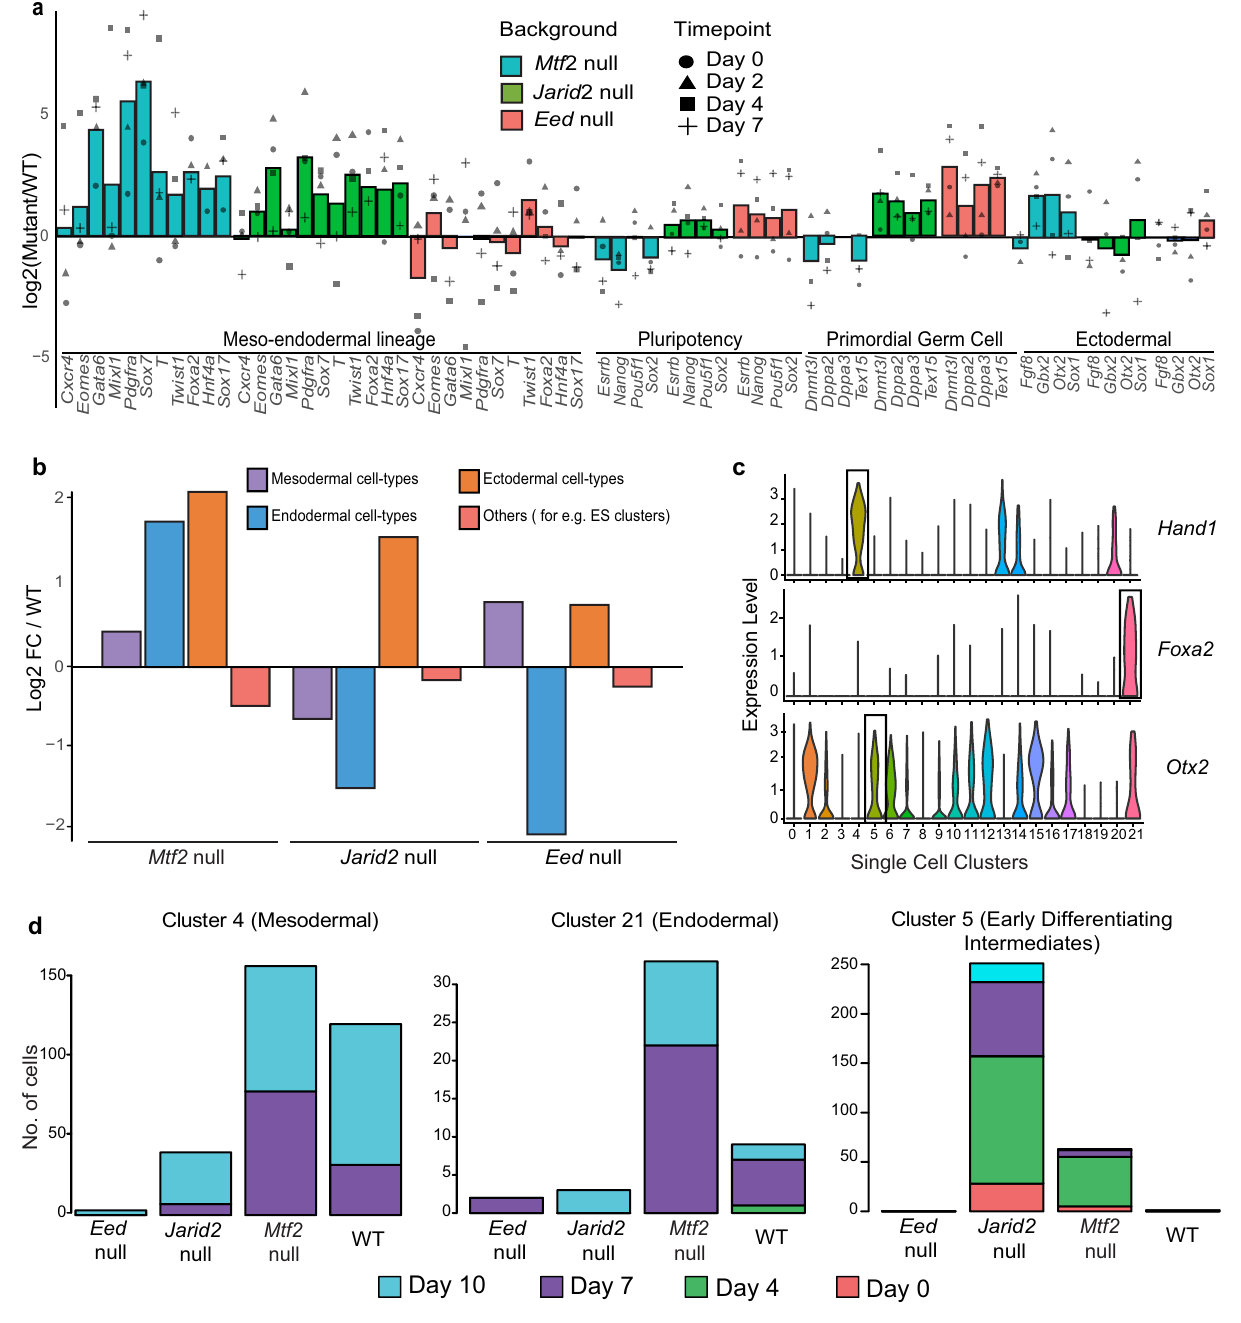
Fig. 2 Altered patterns of lineage commitment in PRC2 mutant embryoid bodies. a Bulk RNA-seq expression of upregulated key lineage markers in different mutant lines over their respective wild types. Bars show average values of all time points, plotted separately by shape. b Barplot showing enrichment of different germ layer cell types from genetic mutants compared against WT, derived from single-cell RNA-seq clusters. c Violin plots depicting expression of key lineage transcription factors across single-cell clusters. d Barplots of respective lineage clusters showing the number of cells from each time point in each single-cell cluster for respective